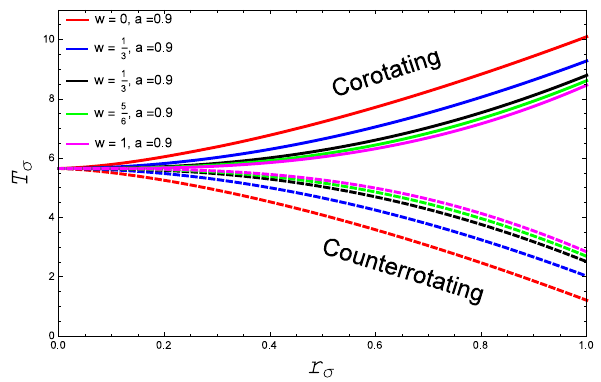
Fig. 3 The plot shows the orbital time period of time-like circular geodesic T σ to the radius r σ . We use units such that M = 1 , a = 0 . 9 and c = 2. Solid lines refer to corotating orbits and dashed lines refer to counterrotating